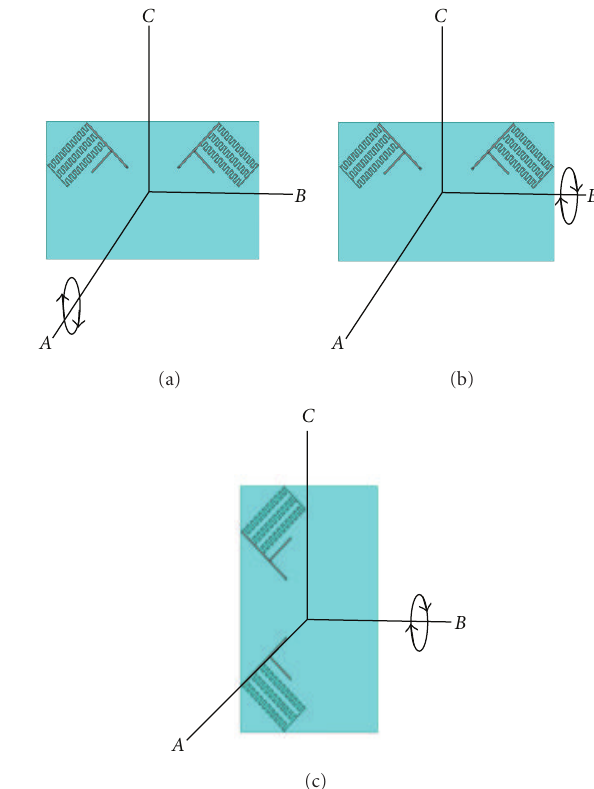
Figure 11: Rotation of antenna: (a) around axis A , (b) around axis B (horizontal antenna position), and (c) around axis B (vertical antenna